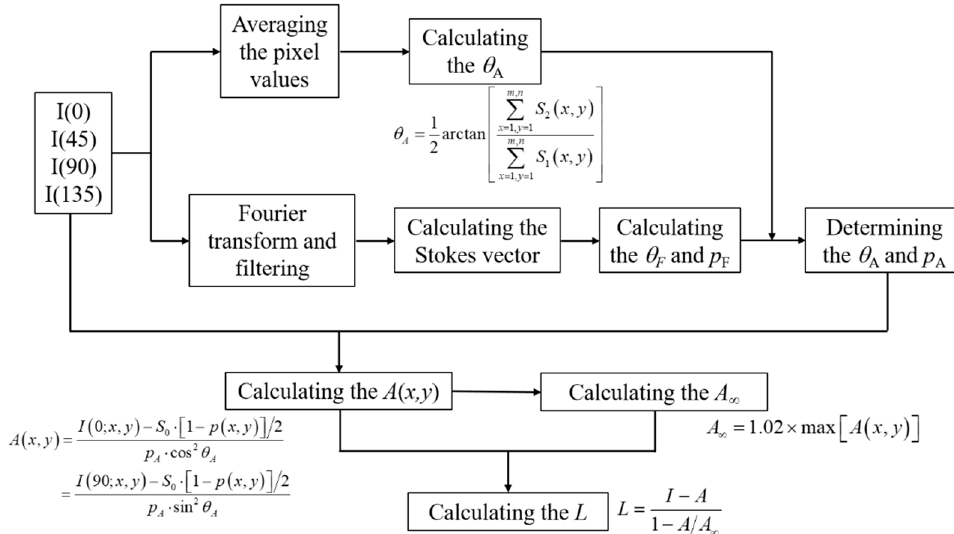
Figure 1. The workflow of the proposed polarirmetric dehazing method.